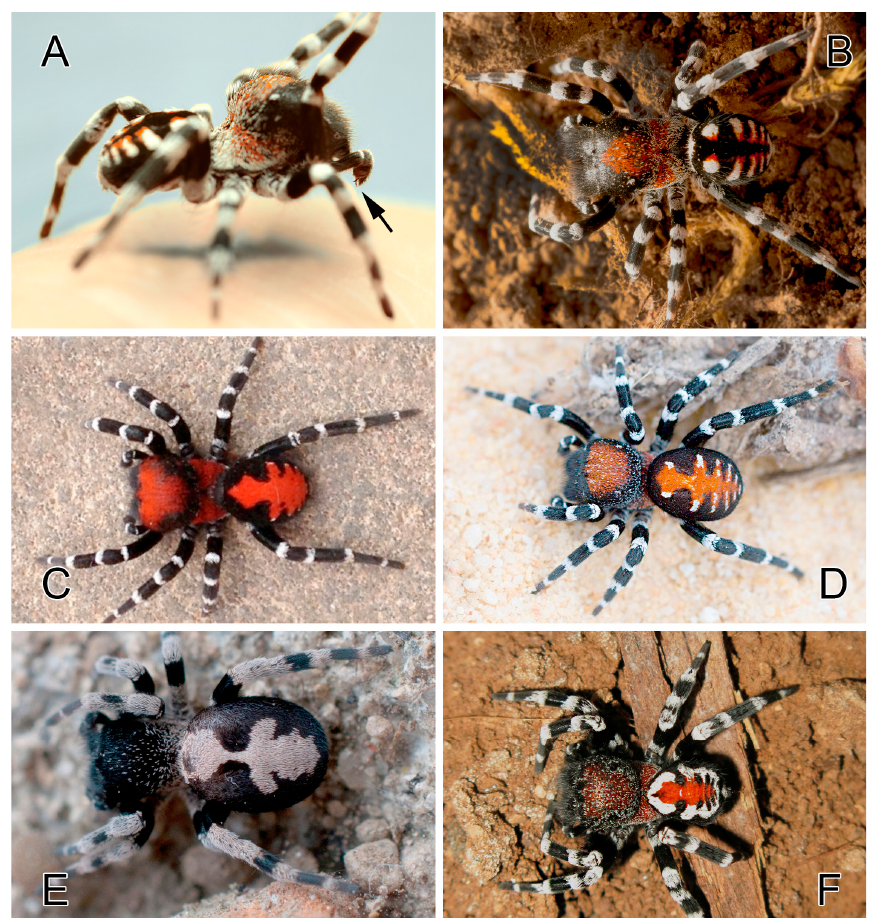
Figure 1. Males of five species of Loureedia . ( A ) L . annulipes from Israel, in a defensive posture, with the bifid conductor visible (arrow) (photo: Tamás Sz ű ts); ( B ) L . annulipes from Israel (photo: Tamás Sz ű ts); ( C ) L. maroccana from Morocco (photo: János Gál); ( D ) L . jerbae from Djerba, Tunisia (photo: Stanislav Macík); ( E ) L . colleni from Spain (photo: Magali Fabregat); ( F ) L. phoenixi from Iran (photo: Alireza Zamani). ( C ) reproduced from Gál et al. [2]; ( F ) reproduced from Zamani and Marusik [6].